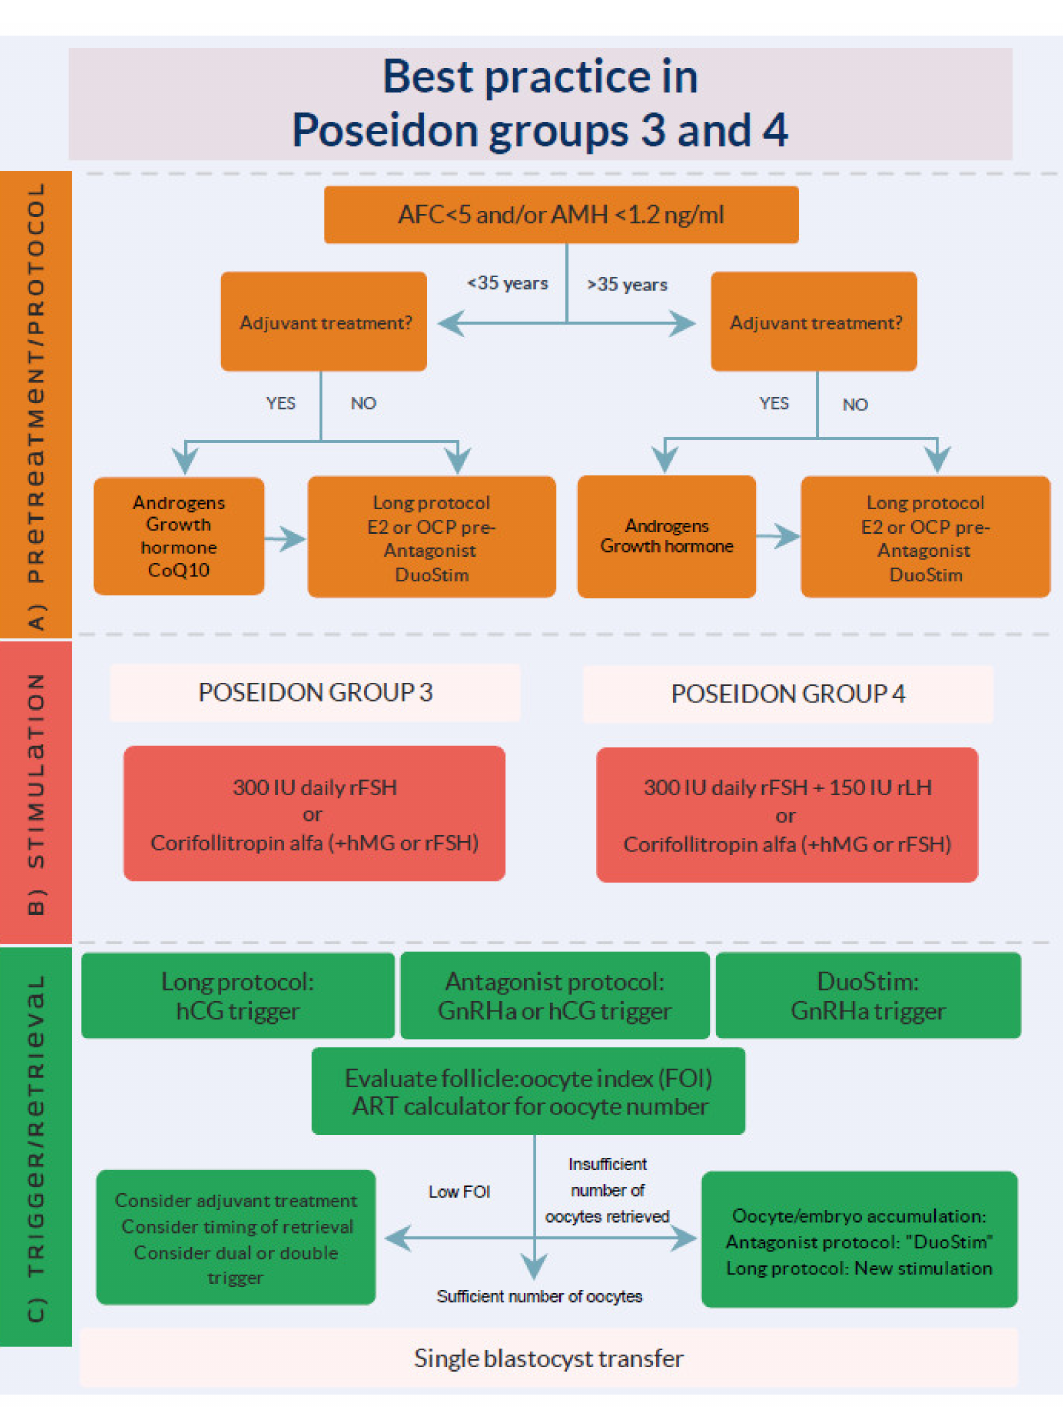
Figure 5. Management of POSEIDON groups 3 and 4. A) Pretreatment is rarely the first option in low-prognosis patients, but in case of inadequate ovarian response to stimulation, pretreatment should be considered. The choice should rely on the availability, clinical experience, and patient preference. Stimulation protocol might start using GnRH antagonist co-treatment, keeping in mind the possibility of converting to DuoStim to increase the chances of achieving the individualized number estimated by the ART calculator. Otherwise, a long GnRHa protocol should be considered as the first choice. B) Ovarian stimulation strategy: The first choice in Poseidon group 3 is the GnRH antagonist cycle with either 300 IU daily of recombinant FSH (rFSH) alone or combined with either recombinant LH (rLH) or human menopausal gonadotropin (hMG). In POSEIDON group 4 patients, 300 IU rFSH combined